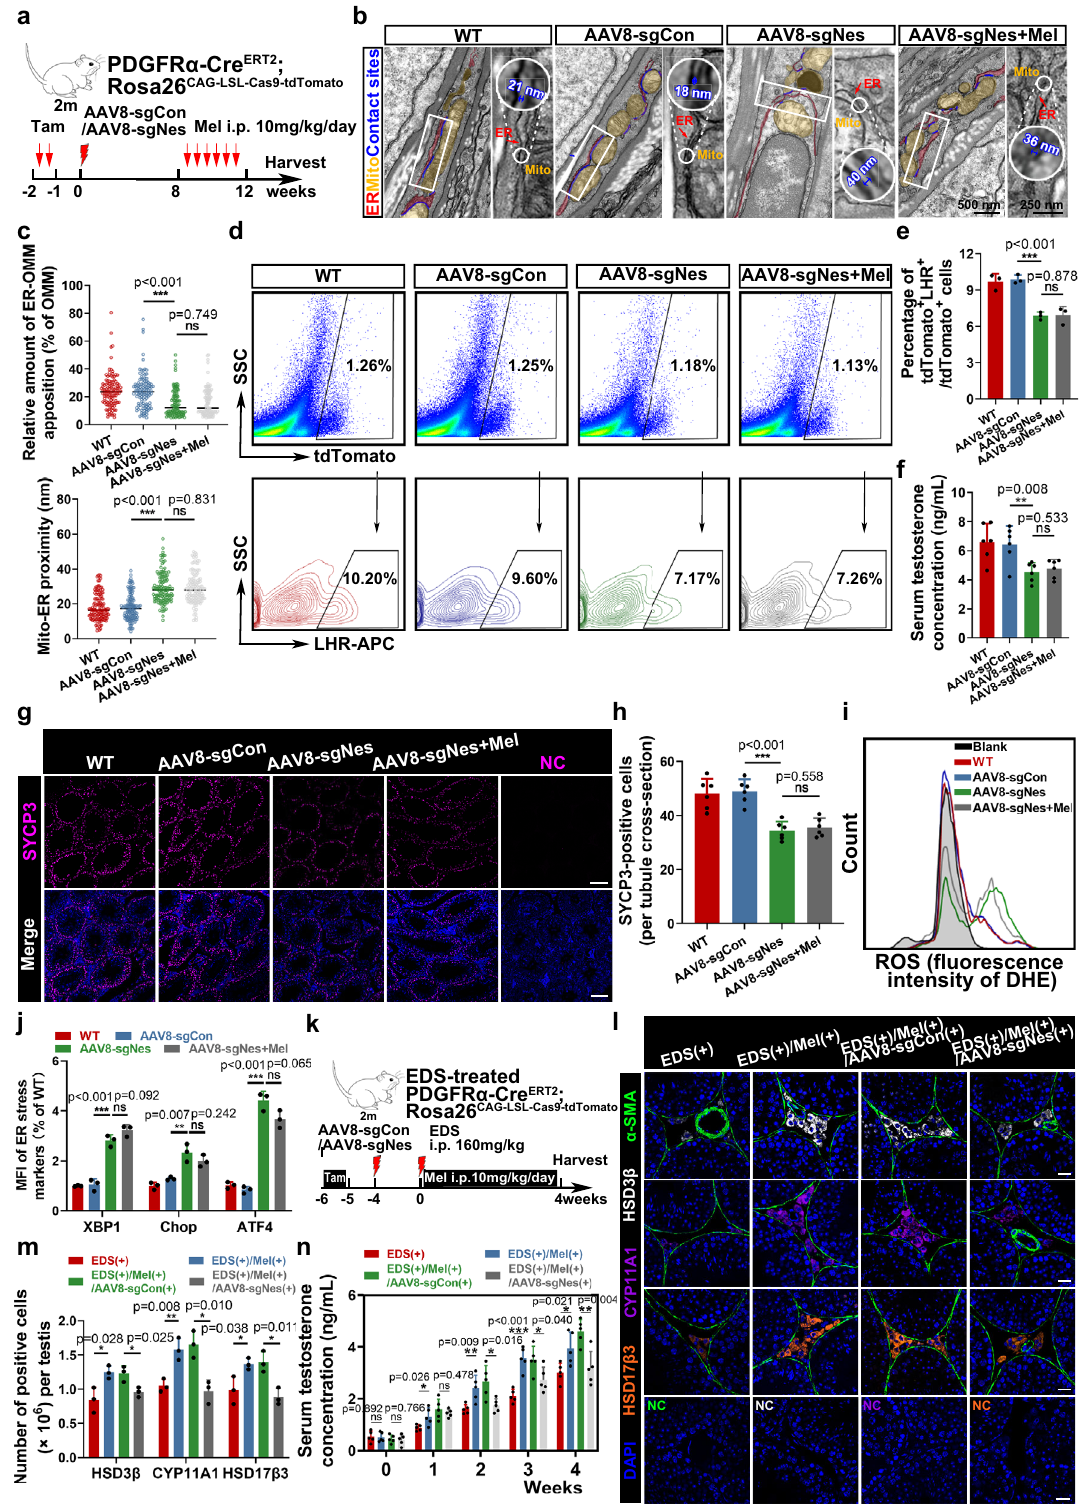
the mea n ± SD of at least three independent experiments. Sample sizes are all presented in the fi gure legends. Statistical analysis between two groups was per- formed using unpaired t -test. Statistical analysis between multiple groups was performed by one-way ANOVA, with Tukey ’ s multiple comparison test. All data were analyzed using Prism software (GraphPad Software). A two-sided p-value < 0.05 was considered to be statistically signi fi cant. The level of signi fi cance de fi ned as p < 0.05 ( * ), p < 0.01 ( ** ), p < 0.001 ( ***